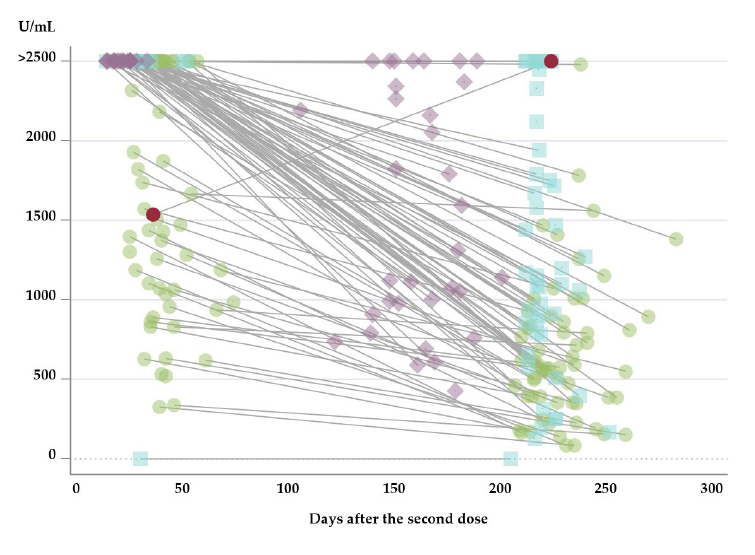
Figure 3. Concentration of antibodies against SARS-CoV-2 spike (S) protein in plasma after comple- tion of the vaccine regimen with the second dose of vaccine. Green circles: BNT/BNT, two doses BNT162b2 mRNA vaccine from Pfizer/BioNTech). Blue squares: m1273/m1273, two doses mRNA- 1273 vaccine from Moderna. Purple diamonds: ChAd/m1273, the heterologous vaccine regimen combining ChAdOx1 vaccine from AstraZeneca with m1273 from Moderna. Paired measurements are marked with lines. The individual marked with red had a PCR-confirmed infection with SARS-CoV-2 between the early and late antibody